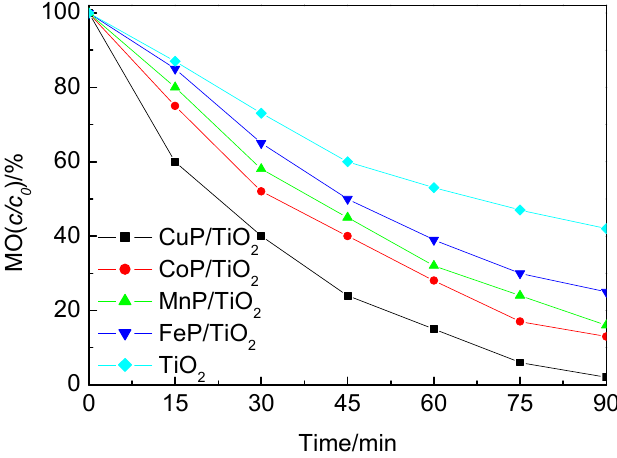
and MP-TiO catalysts under ultraviolet light 2 2